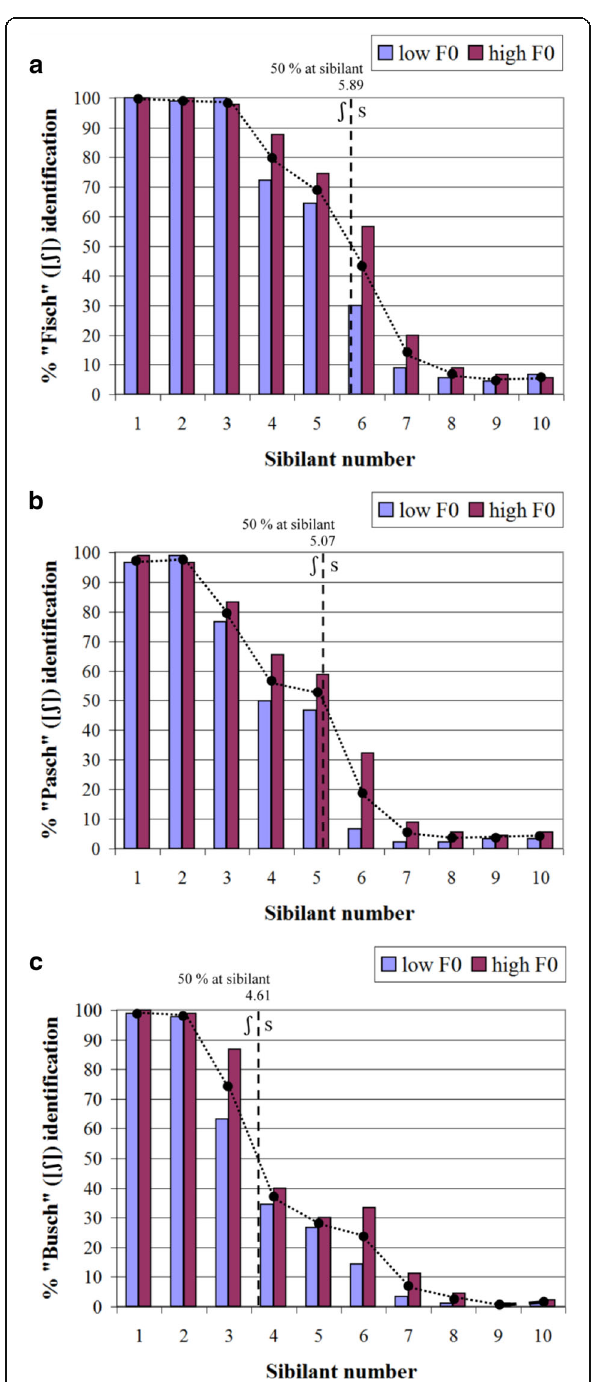
Fig. 7 Summary of the word-identification judgments. The three panels ( a – c ) show the relative frequencies of sentence-final target words being perceived as ending in [S] (i.e. Fisch , Pasch , Busch ) in the rising ( dark bars ) and falling ( light bars ) F0 contexts; n = 180 for each bar. Dotted lines represent the average percentages across ris- ing and falling F0 contexts and vertical dashed lines show the 50% cross-over point between [ ʃ ] and [s] identification, estimated by means of logistic regression